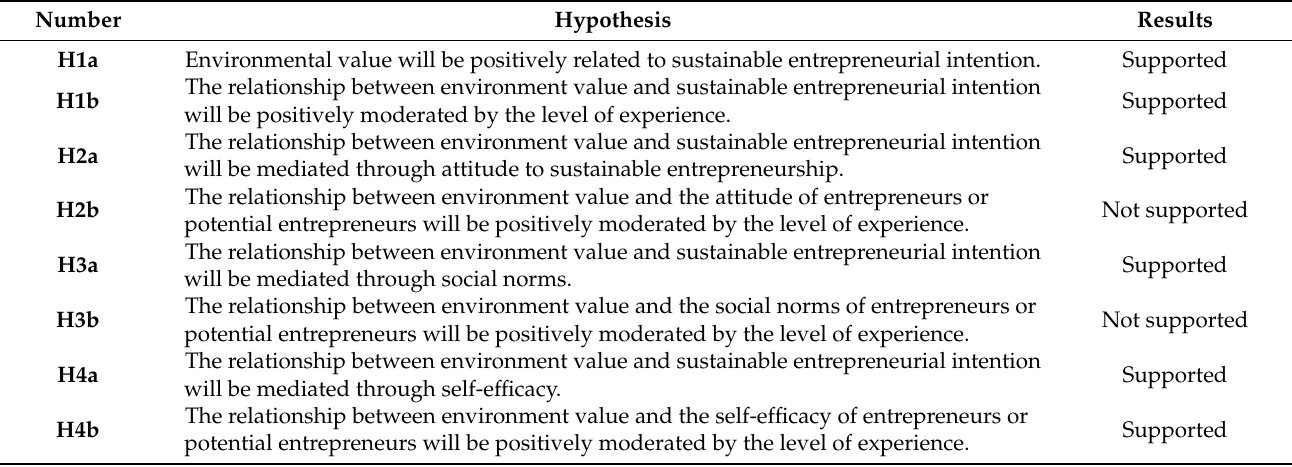
Table 5. The overall results of environment value and sustainable entrepreneurial intention. Number Hypothesis H1a